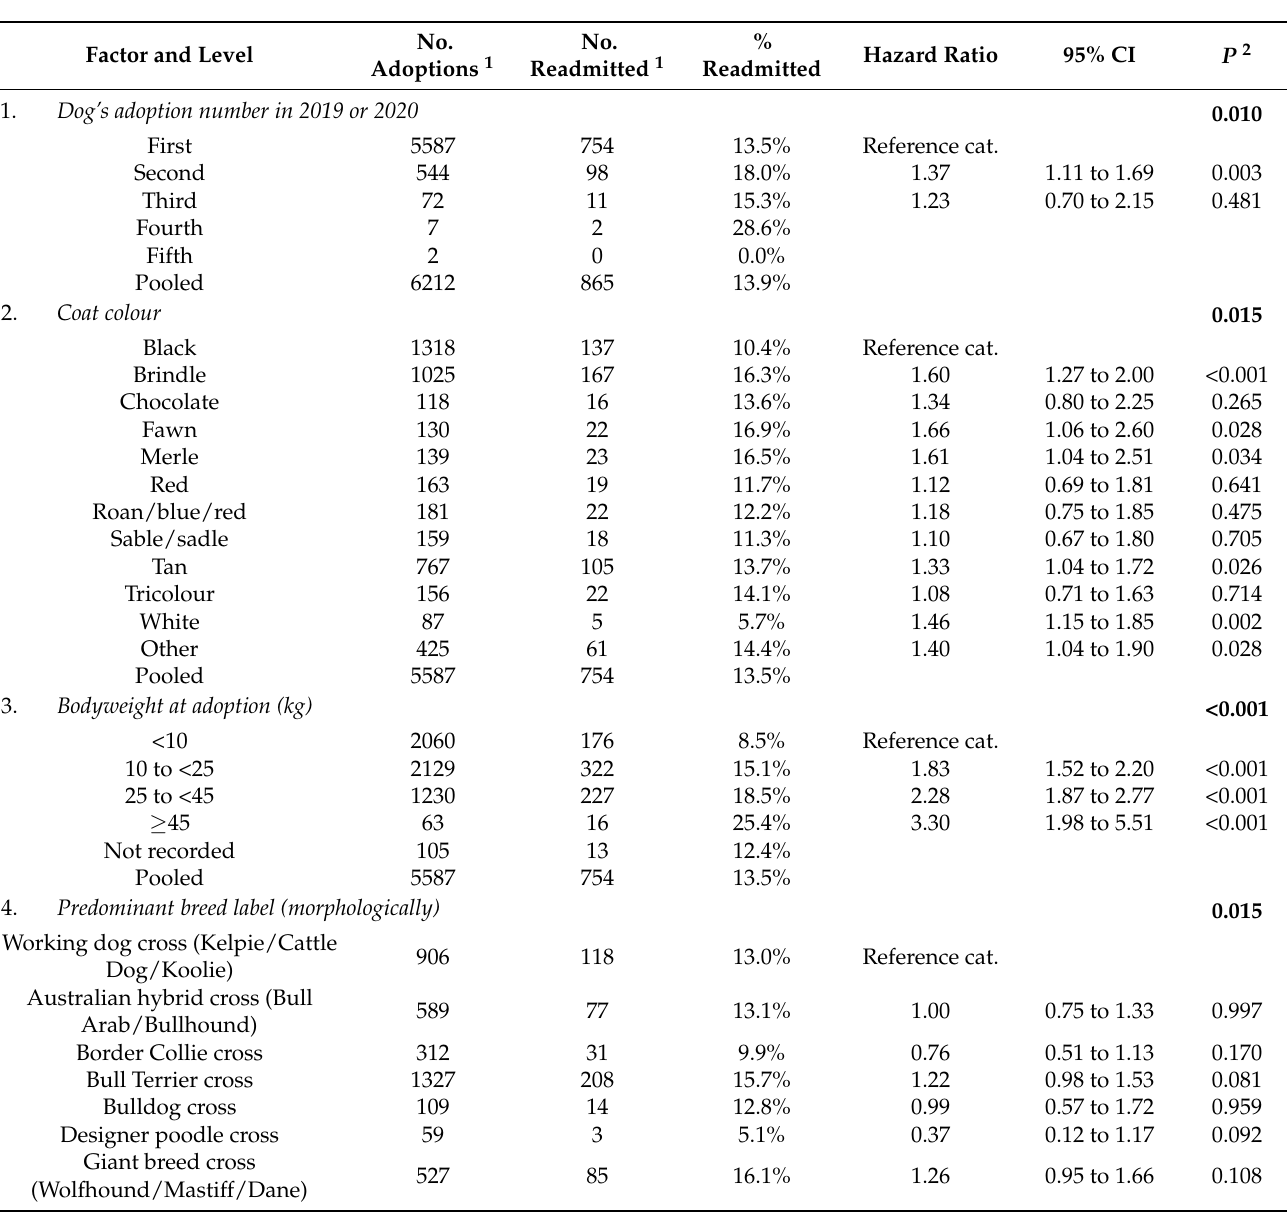
Table 2. Descriptive statistics and hazard ratio estimates for exposure variables with low overall p -values on univariable analyses of associations with time to readmission for dogs adopted from RSPCA Queensland in 2019 and